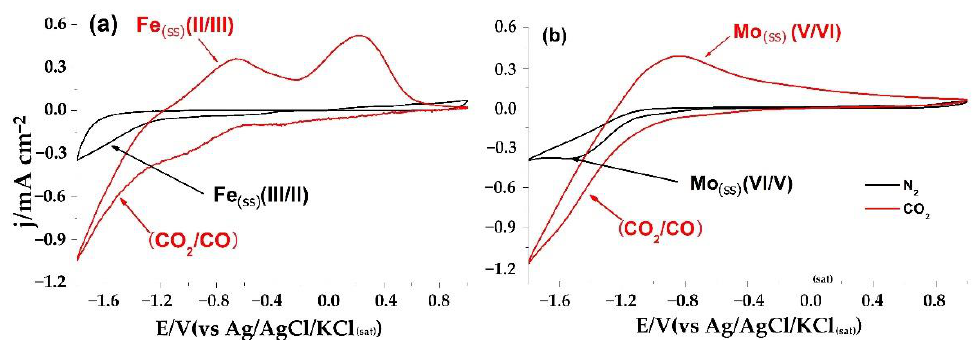
Figure 1. Cyclic voltammograms for CO 2 reduction over thin-film electrodes: ( a ) Fe 2 O 3 and ( b ) MoO 3 in 0.1 M TBAF/ACN electrolyte solutions; black and red plots correspond to CO 2 and N 2 purged electrolytes, respectively. (ss) corresponds to metal atoms in surface states.